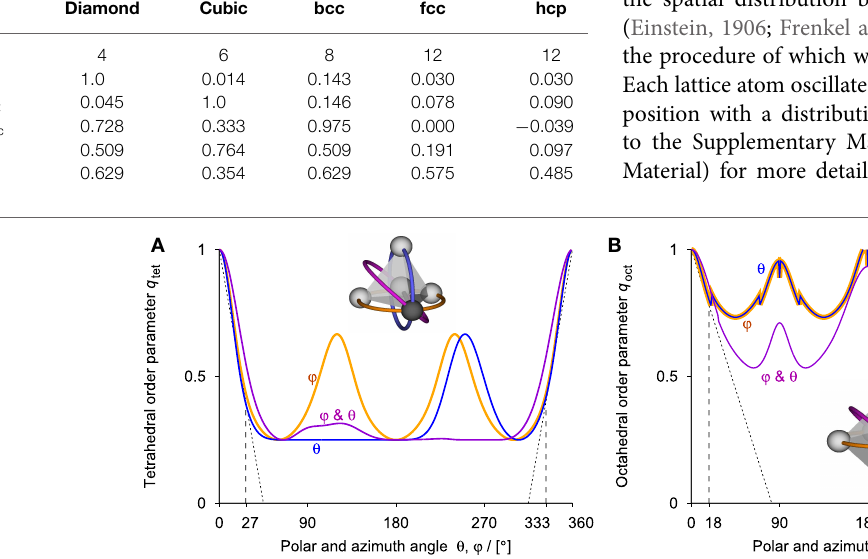
FIGURE 4 | Responses of (A) tetrahedral, q tet , and (B) octahedral order parameter, q oct , to well-defined perturbations of a single neighbor in the corresponding perfect structure motif along the azimuth (orange) and polar (blue) angle as well as an intermediate path (purple). Peaks at intermediate angles indicate overlapping